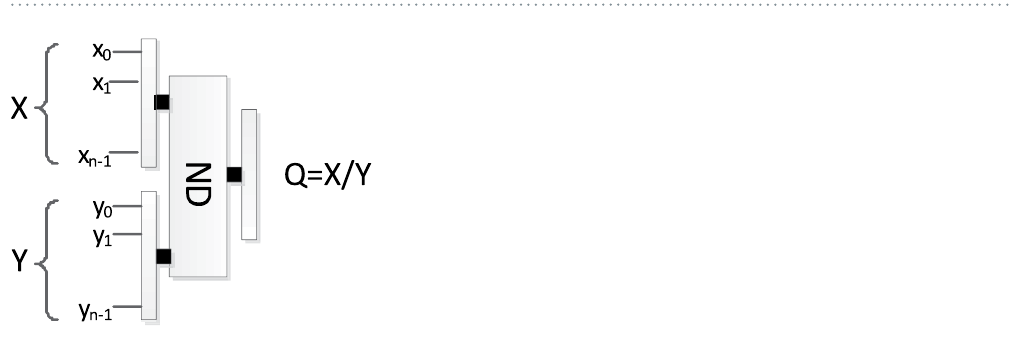
Figure 21. The simplified graph of the quantum division